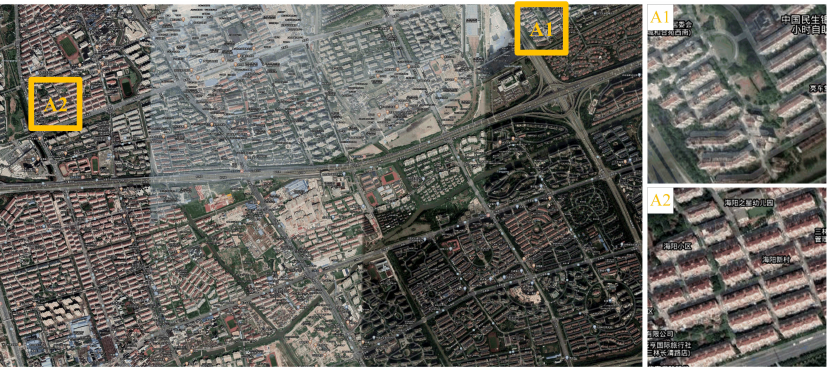
Figure 16. The generation results with level 17 via the proposed CscGAN in Qingpu District of Shanghai. For clarity, the zoomed local areas (A1 and A2) are on the right of the figure.